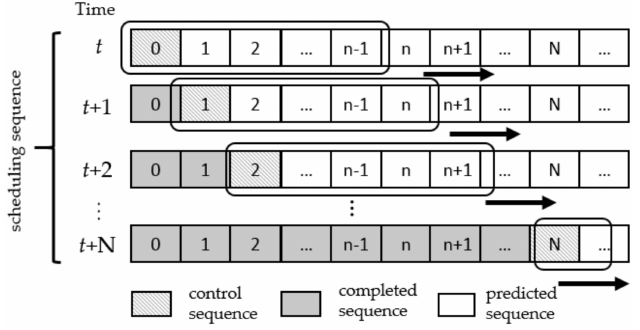
Figure 6. Explanation of time sequences in rolling optimization of